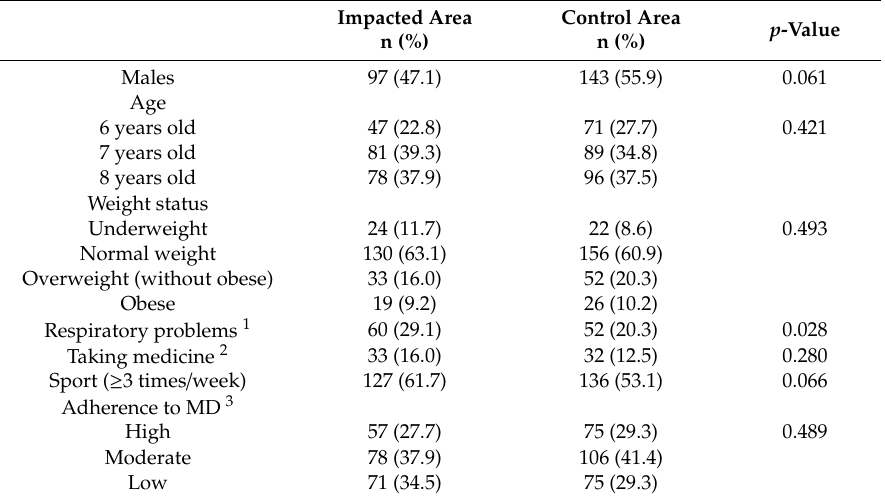
Table 2. Individual characteristics of children recruited in the two areas.